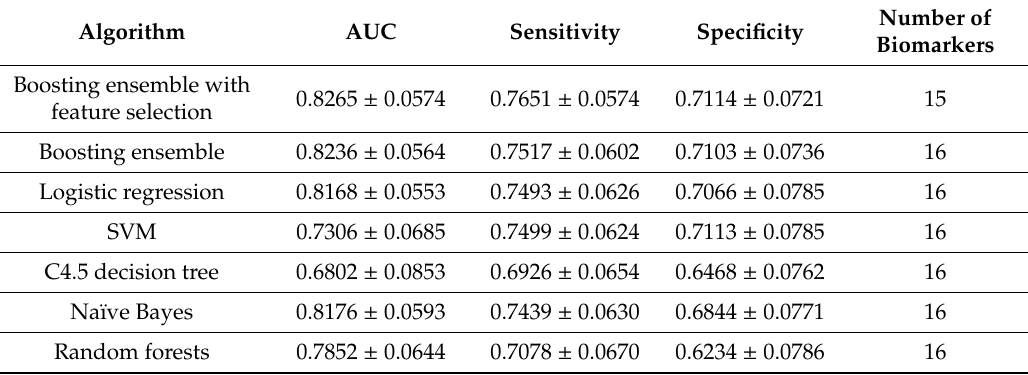
Table 1. The results of repeated 10-fold cross-validation experiments for predicting treatment response with genetic variants and clinical variables using the boosting ensemble model with feature selection, the boosting ensemble model, logistic regression, SVM, C4.5 decision tree, naïve Bayes, and random